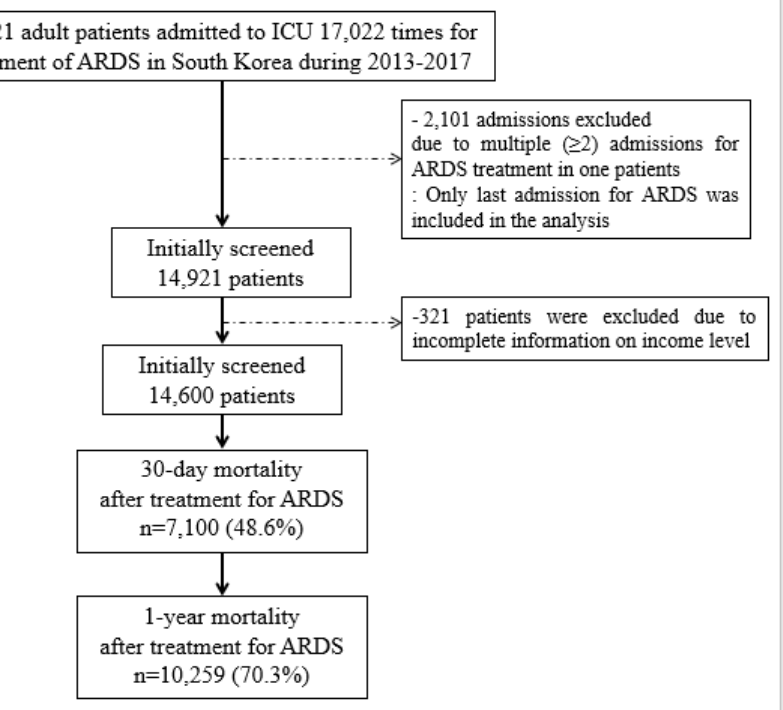
Figure 1. Flow chart depicting patient selection. ARDS, acute respiratory distress syndrome.